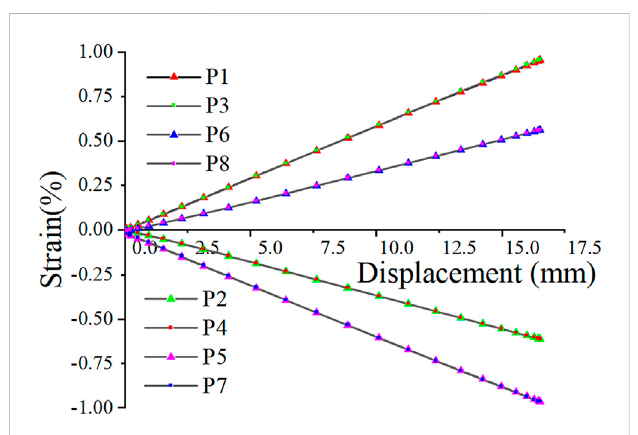
FIGURE 10 Strain-displacement curves of points on the hoop reinforcement